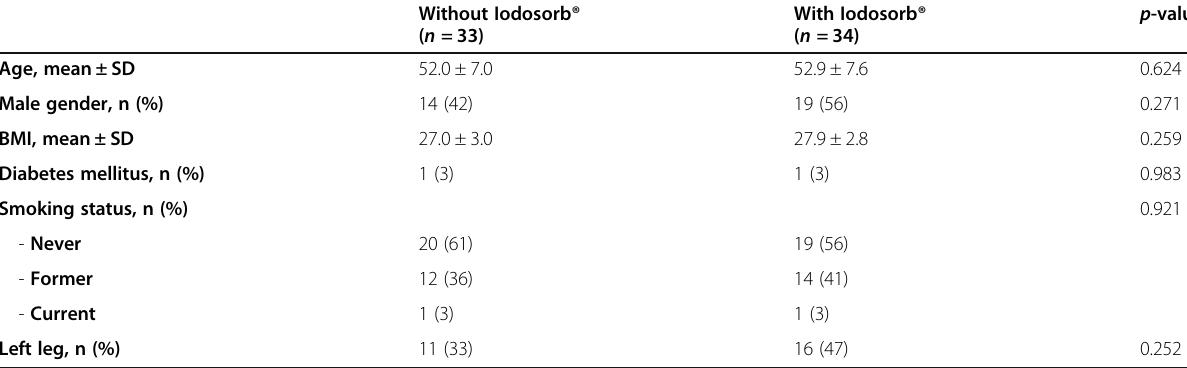
Table 1 Baseline characteristics of knee joint distraction patients with or without cadoxemer iodine